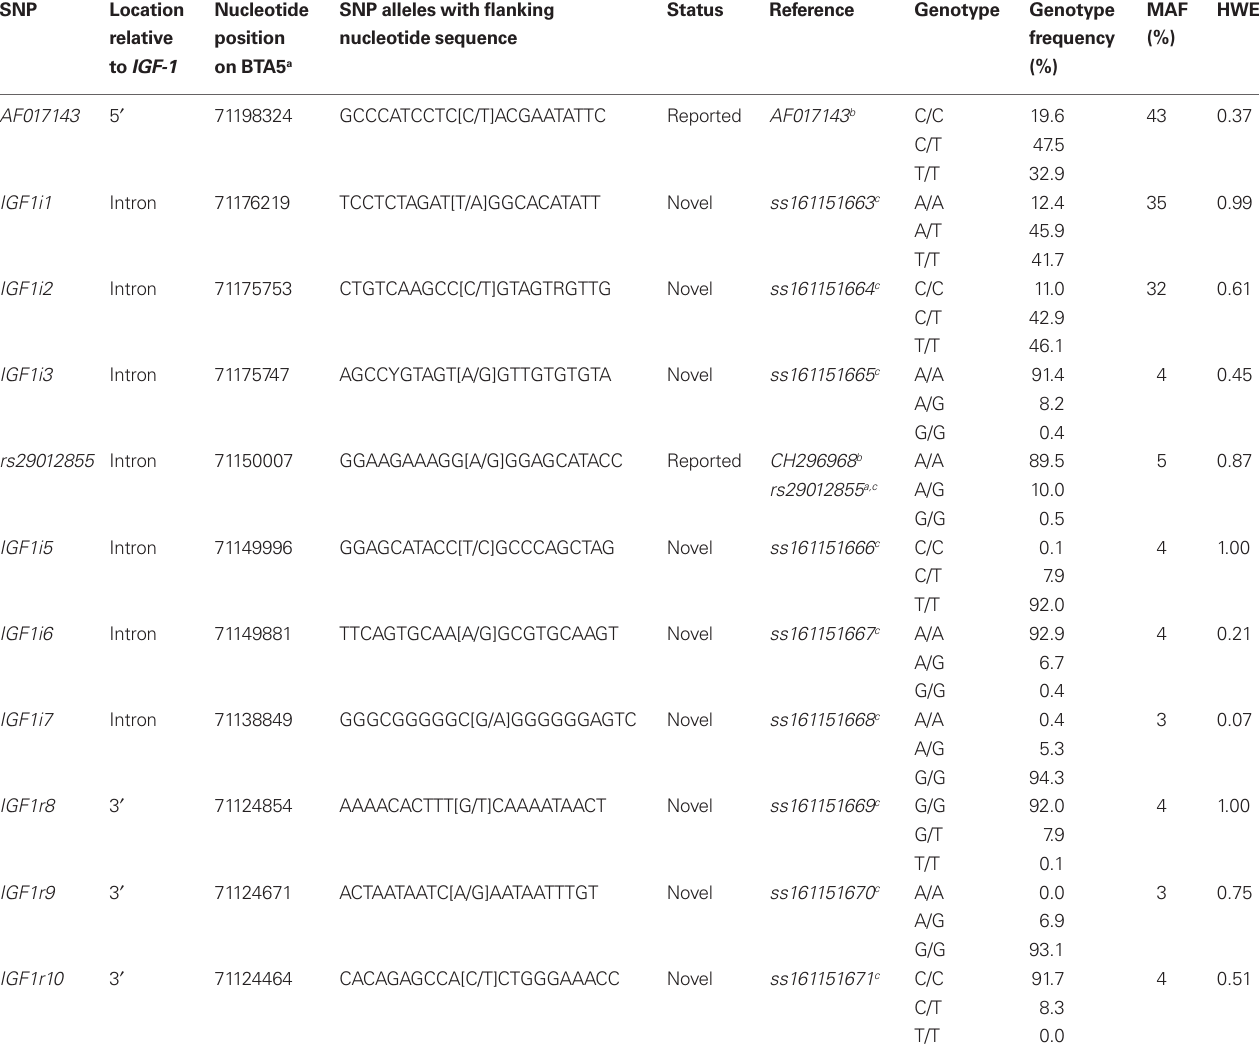
Table 3 | Location, nomenclature, genotype frequency, minor allele frequency (MAF), and significance of deviation from Hardy–Weinberg equilibrium (HWe) for the 11 segregating SNPs in the 848 Holstein-Friesian sires.